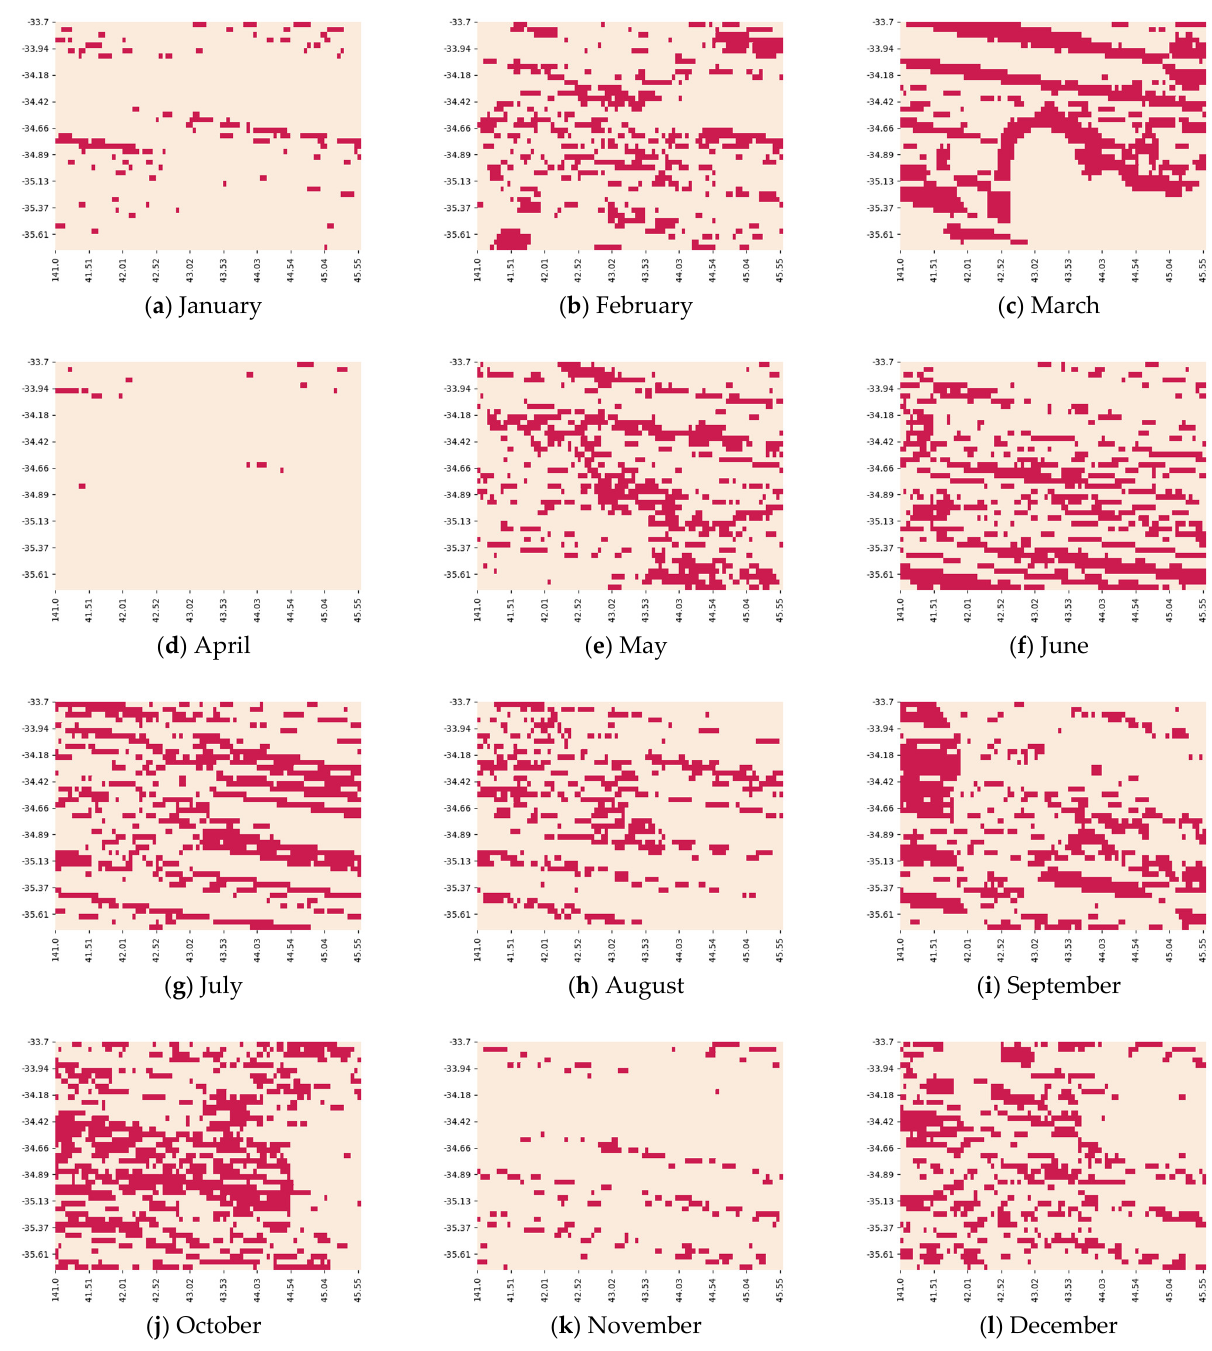
Figure A2. Heatmaps of the geolocated grids for Grassland Region of Australia in 2015 for 12 months. Cream colour denotes the grids which are not classified correctly. Red colour indicates the grids which are classified correctly. Figures ( a – l ) represent the heat map for 12 different months, respectively.